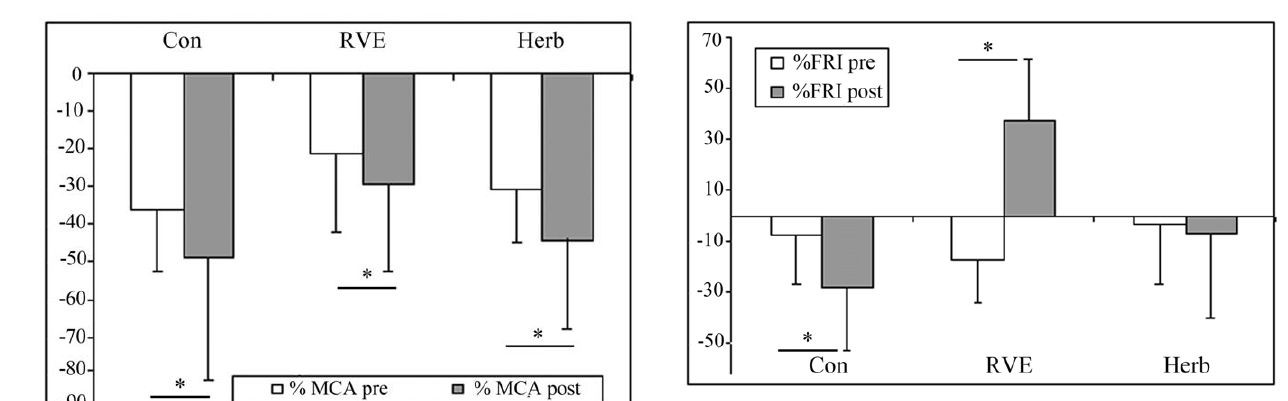
Figure 1. Percentage change in flow velocity in the middle cerebral artery (MCA) from the supine to tilt positions. The MCA was measured by Doppler ultrasonography as detailed in the Materials and Methods section. Percentage change in flow velocity in the MCA from the supine to tilt positions was significantly increased after 60-day HDBR in all groups (P , 0.05).